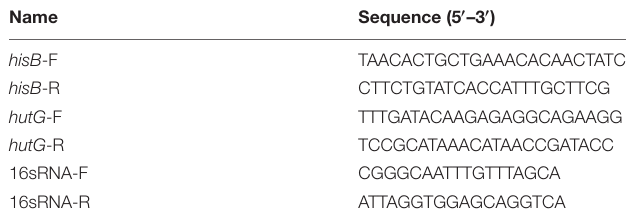
TABLE 4 | Primers used for real-time PCR in this